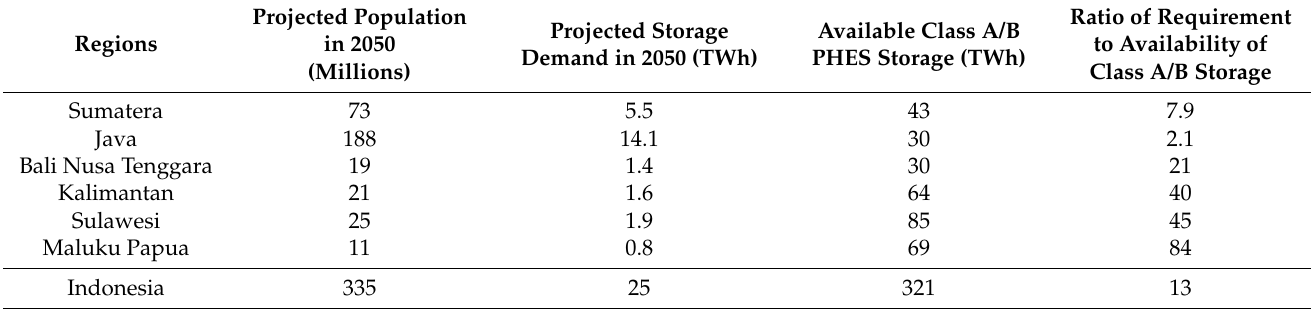
Table 3. Class A and B Greenfield PHES storage availability for Indonesian regions compared with upper bound requirements in